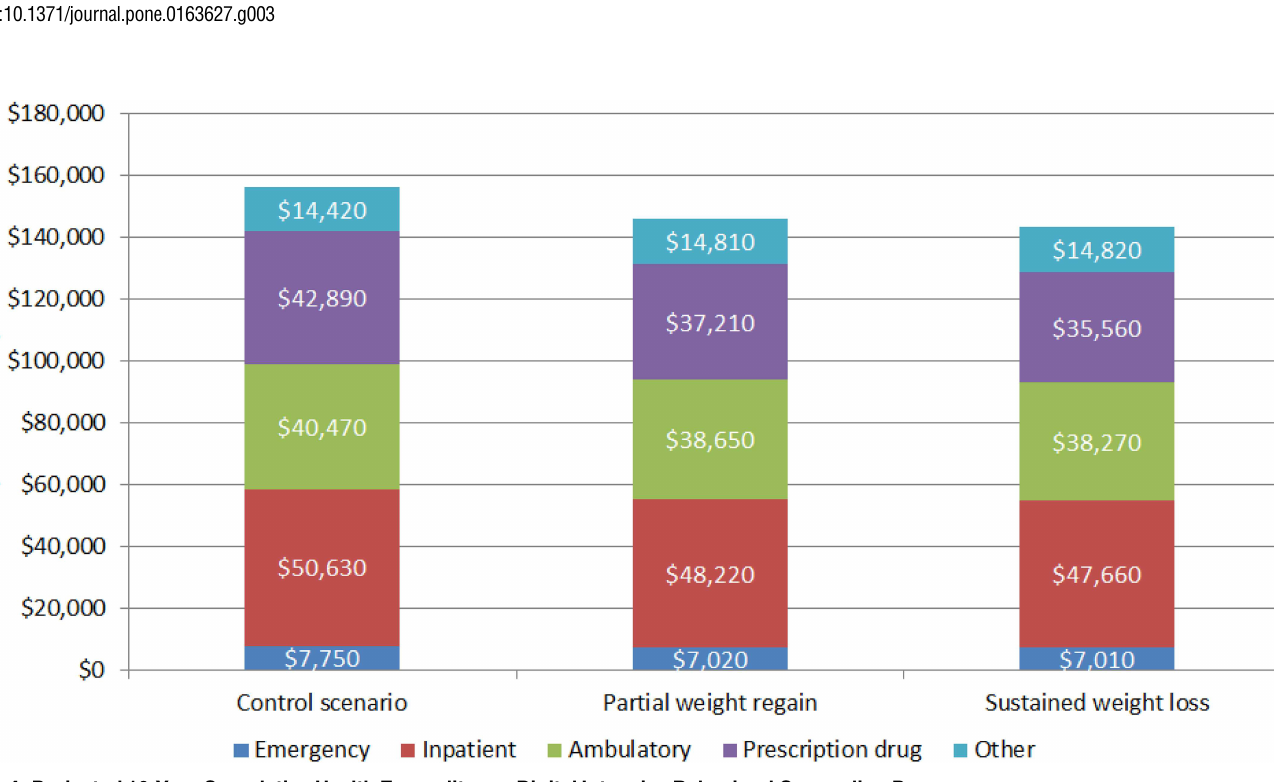
Fig 4. Projected 10-YearCumulative Health Expenditures, Digital Intensive Behavioral Counseling